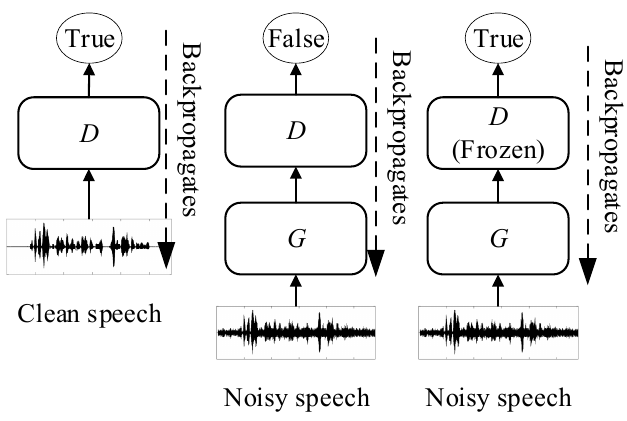
Figure 1. Adversarial training for speech enhancement.